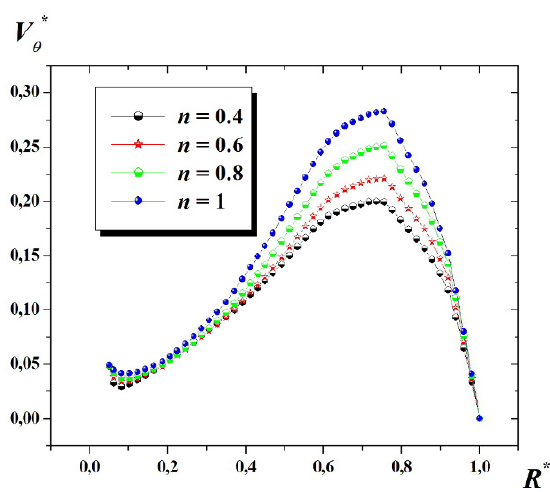
Figure 8. Radial velocity for double helical ribbon impeller, at Re 60 , R ∗ = 0 . 74 , θ = 0 0 .